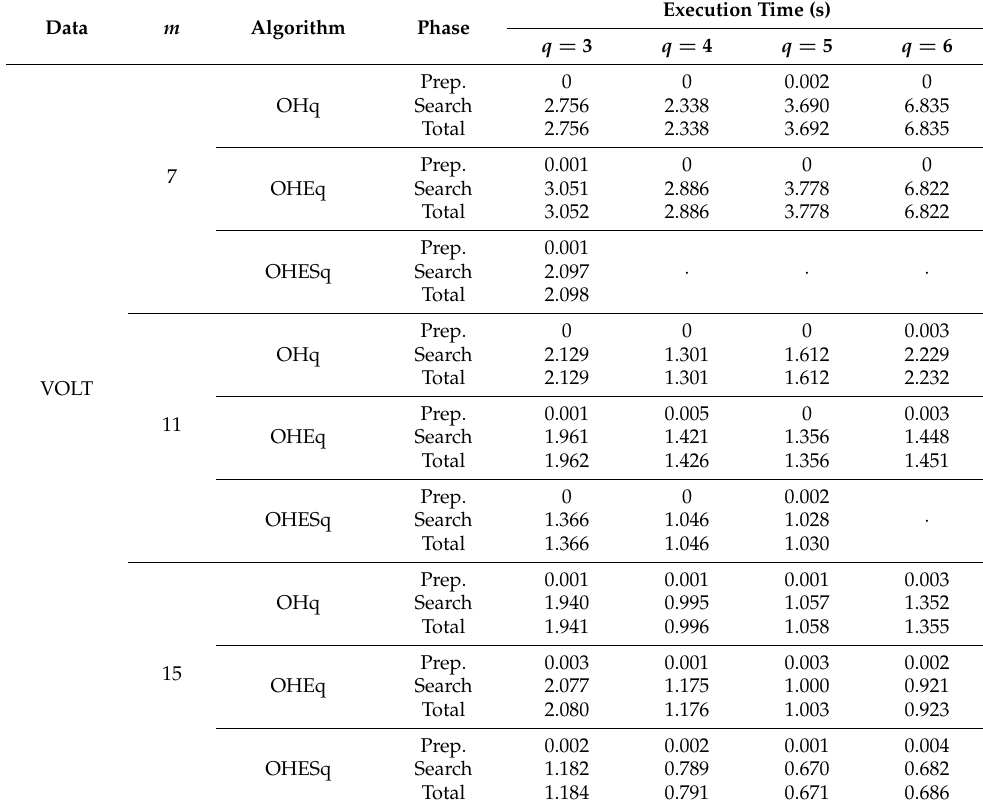
Table A1. Execution times of 1000 patterns for VOLT